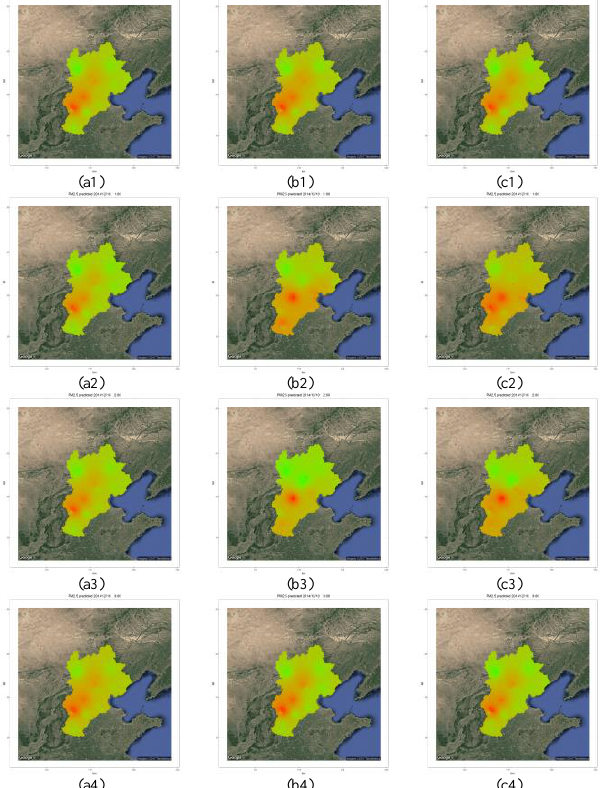
Figure 11. Prediction distribution of PM 2.5 by DRNN2 models from 0:00 to 3:00 a.m. on 12/10/2014. (a) forward-fix,